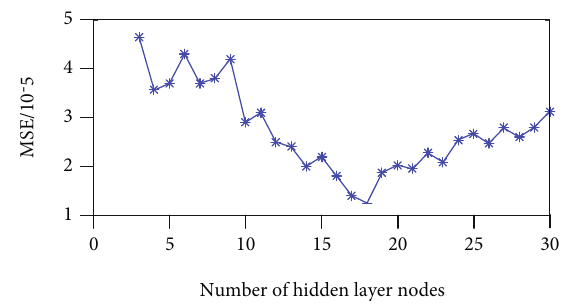
Figure 5: Test results of the number of hidden-layer